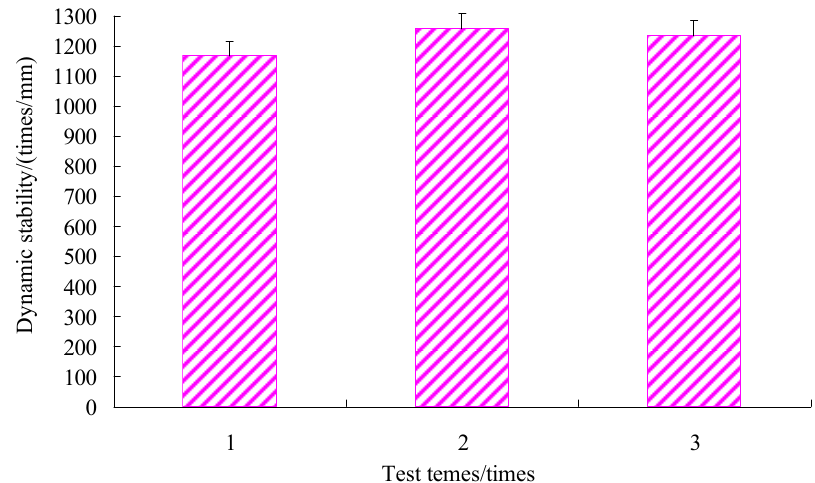
Figure 10. Dynamic stability of the rutting test at 60 °C .